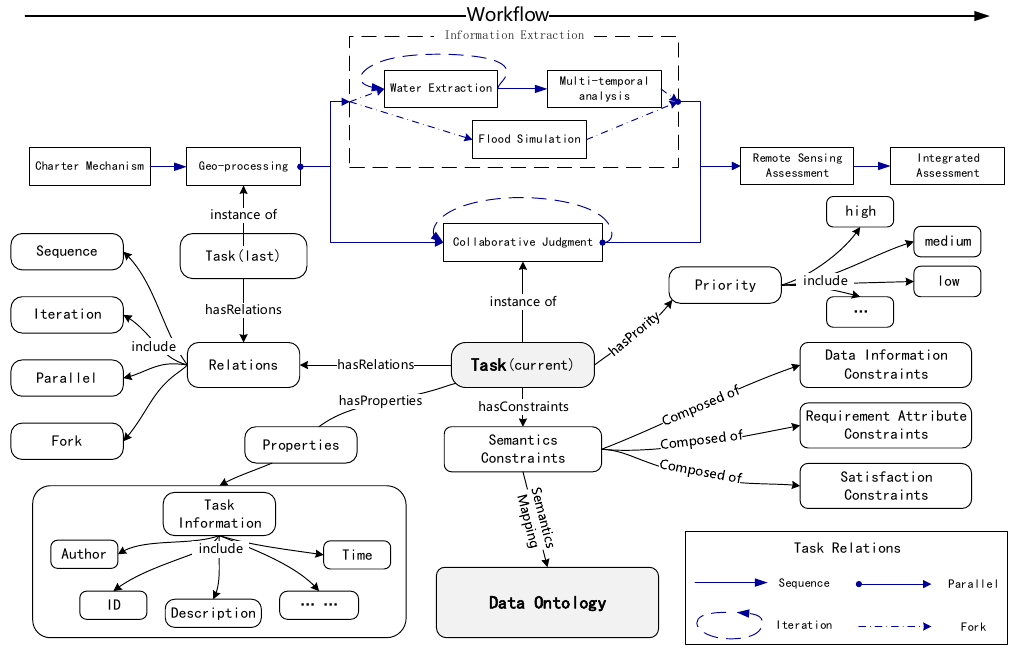
Figure 1. Structure of a task ontology in an emergency response workflow